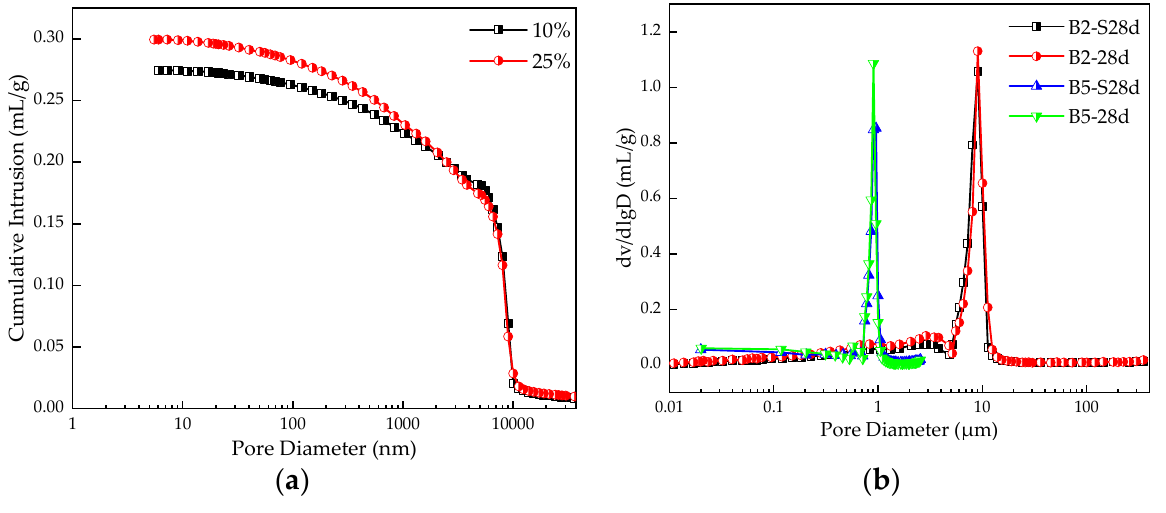
Figure 15. MIP results for stabilized silt ( a ) Cumulative porosity curve, ( b ) Log differential invasion curve. The relationship between cumulative invasion volume and log of pore size of stabilized silt under different curing conditions and different TS content is shown in Figure 15b. The average pore size of a 28 d curing sample with 10% TS content is 9.6 µ m, and the peak pore volume under standard curing is 1.09 mL/g while that underwater curing is 0.85 mL/g. Similarly, when the TS content is 25%, the pore volume peaks of standard curing and water curing show 1.13 mL/g and 1.06 mL/g,